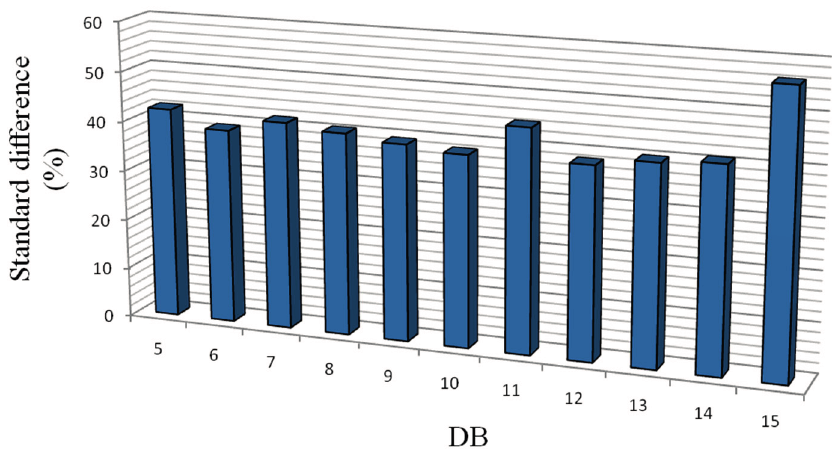
Figure 5. Damage identification results using different wavelet